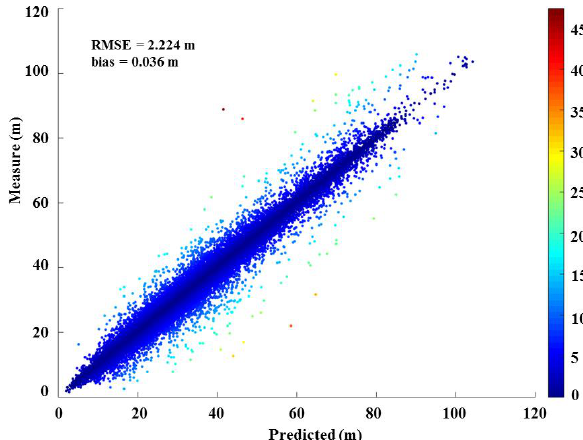
Figure 2. Scatter-plot of predicted and measure depths of the Ordinary Kriging